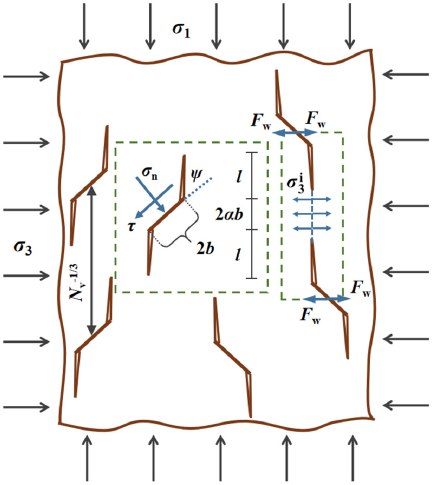
Figure 3. Schematic of the micromechanical model.